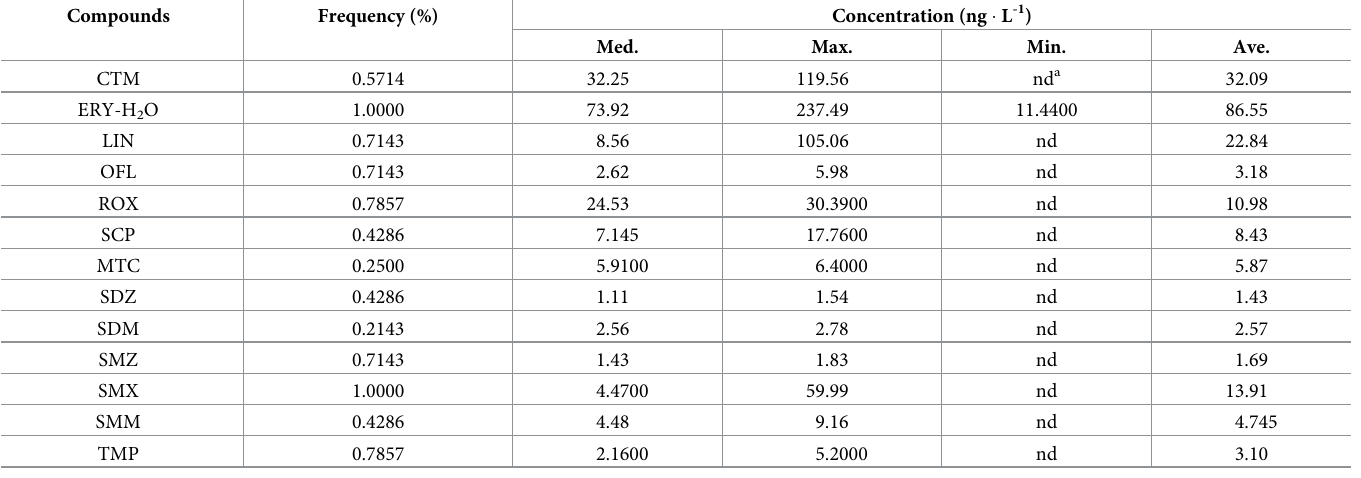
Table 4. Concentrations of antibiotics detected in the receiving waters of